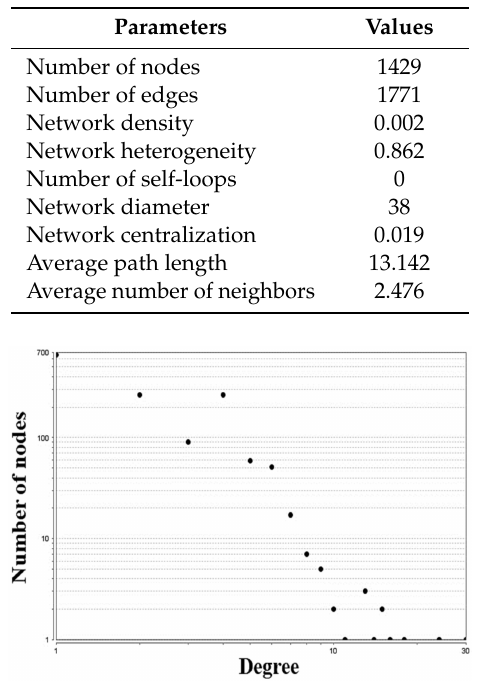
Figure 1. Topological properties of the reconstructed network for healthy ruminal epithelium. Node degree